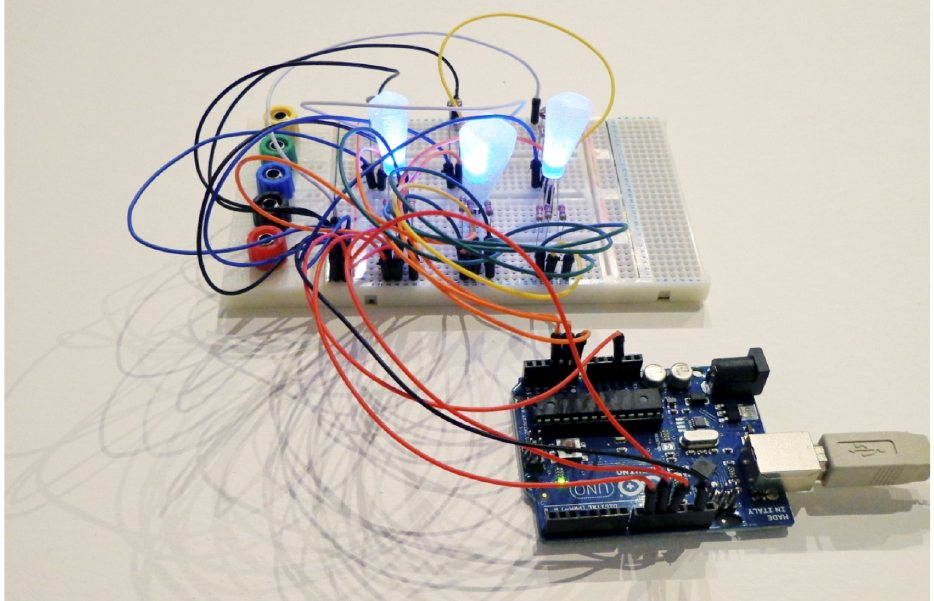
Figure 10 | Arduino Uno RGB LED Colour Organ, Katharina Vones